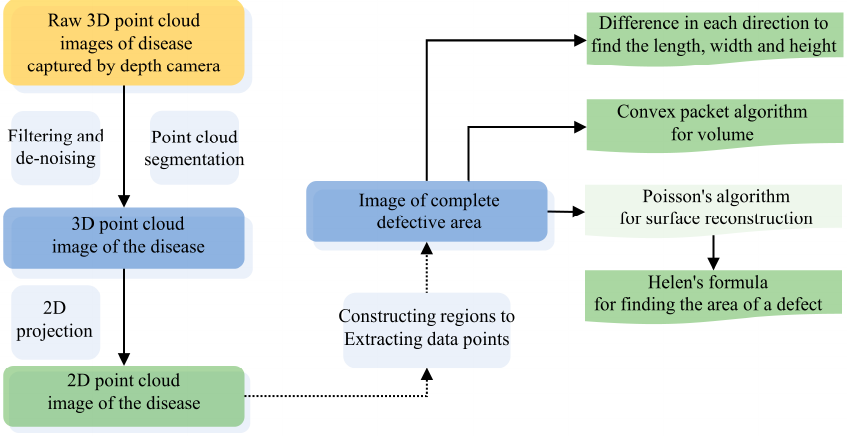
Figure 7. Three-Dimensional Point Cloud Processing Flow Chart. The depth camera can obtain the three-dimensional coordinate values of each point of the damage, calculate the distance between the damage and the camera, and then realise the modelling of the three-dimensional damage in order to grasp the real value of damage